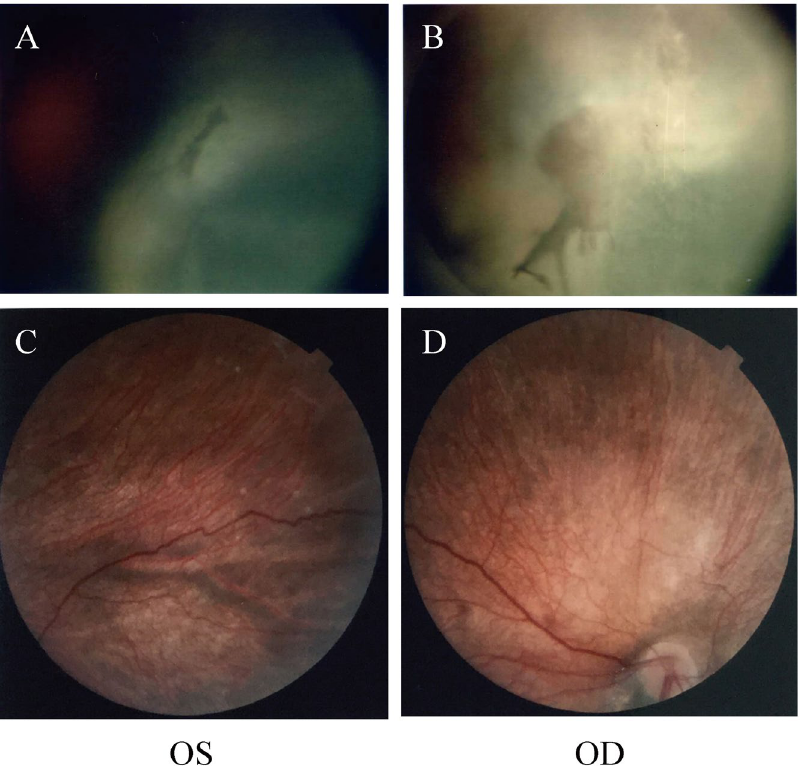
Figure 1. Fundus photography of patient 1 and patient 3. Fundus photography in patient 1 ( A and B ) showing right (OD) cataract, left (OS) optic nerve atrophy, and left retinal dysplasia. Fundus photography in patient 3 ( C and D ) showing retinal and choroidal pigment epithelium atrophy and optic nerve